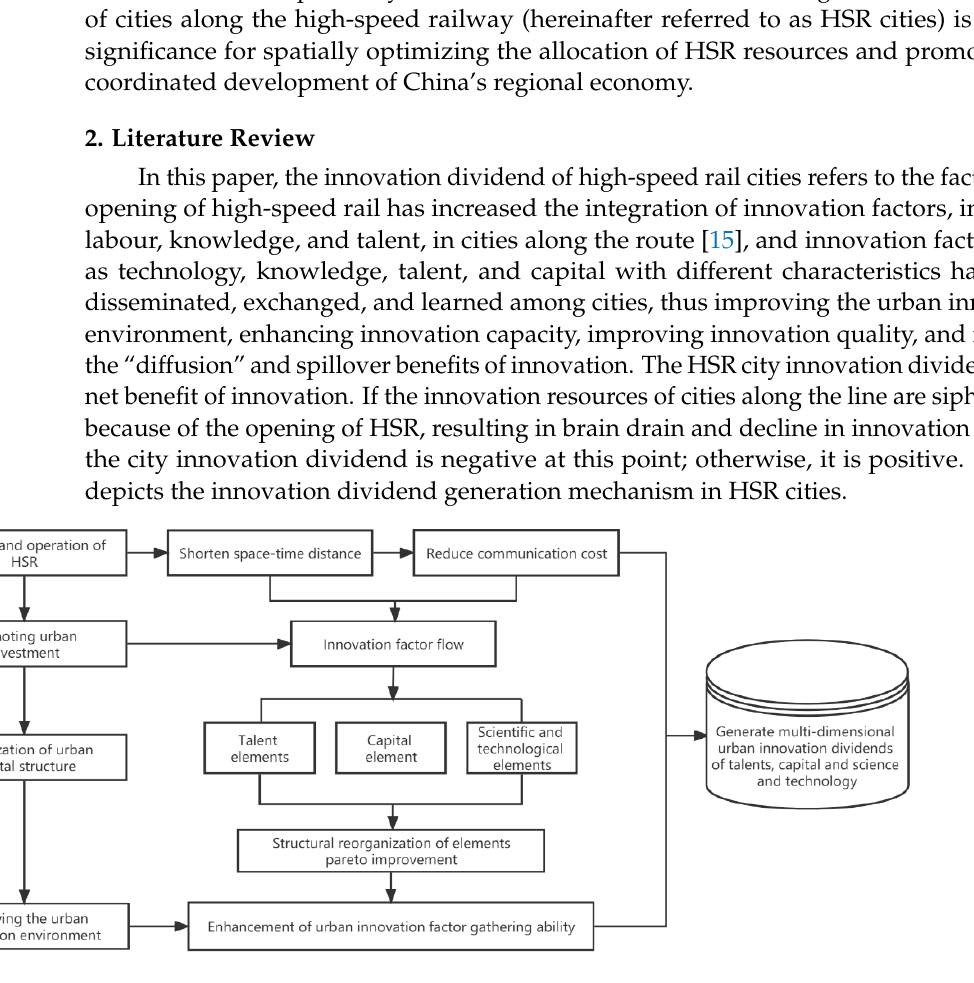
Figure 1. Generation mechanism of innovation dividend in high-speed rail cities.